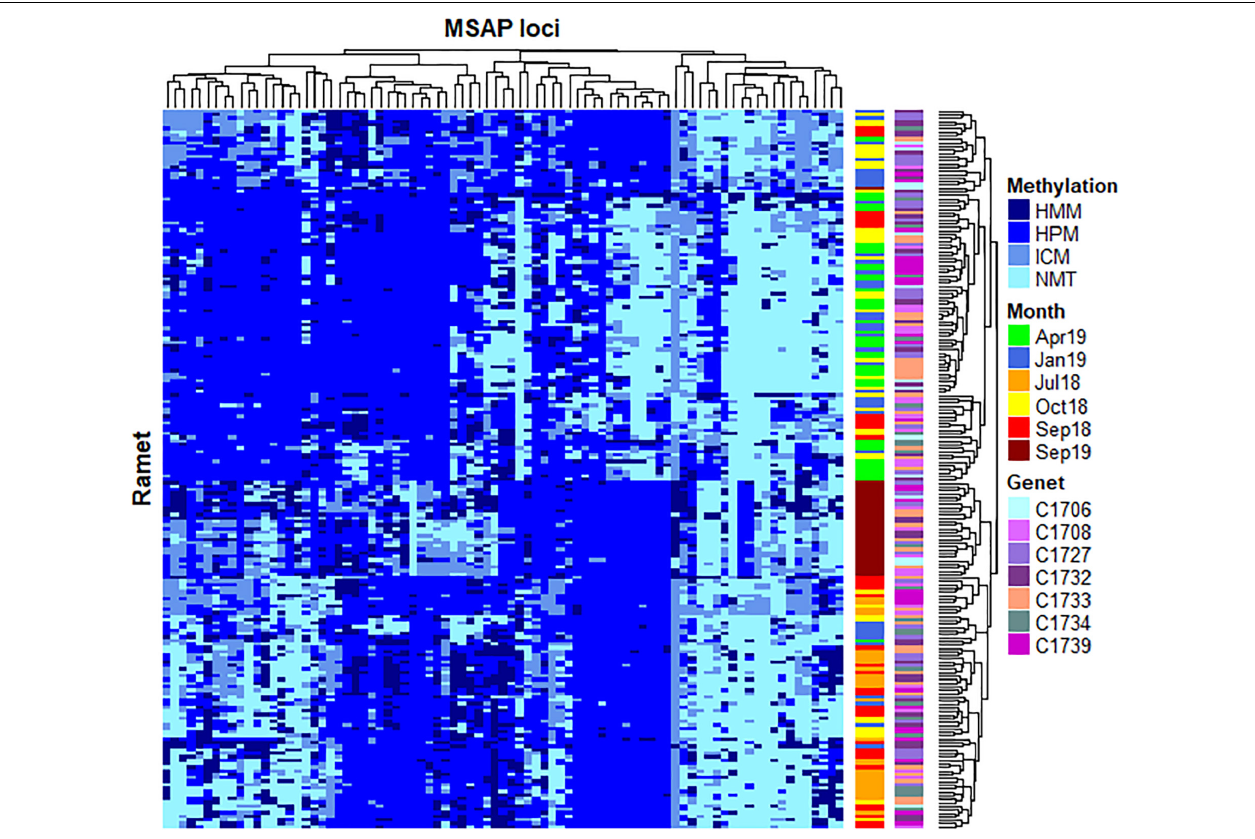
FIGURE 2 | Heatmap representing temporal changes in 83 loci showing a significant non-random distribution of DNA methylation patterns ( p < 0.05, pFDR < 0.05). Two distinctive clusters separate DNA methylation between cold (April 2019) and warm (July 2018, September 2018 and September 2019) months. Samples from October 2018 and January 2019 show a scattered distribution across these two clusters, while most September 2019 specimens constituted a well-defined sub-cluster within the warm group. No clear clustering is observed for specific genets. Rows (samples) and columns (MSAP loci) were clustered using Gower’s Coefficient of Similarity. The methylation status of each locus is indicated in the right margin of the figure: HMM, hemimethylated; HPM, hypermethylated; ICM, internal cytosine methylation; NMT, non-methylated (unmethylated).